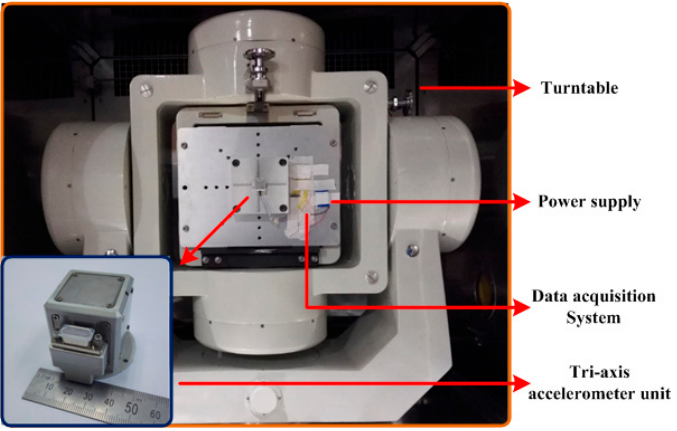
Figure 4. Ground experimental equipment.